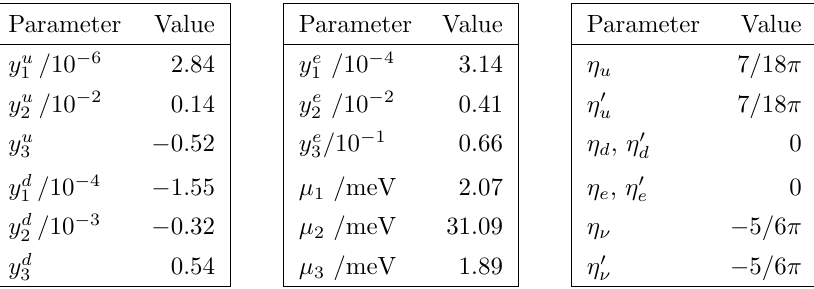
Table 3 . Model parameters to generate the (cid:12)t in table 2 for